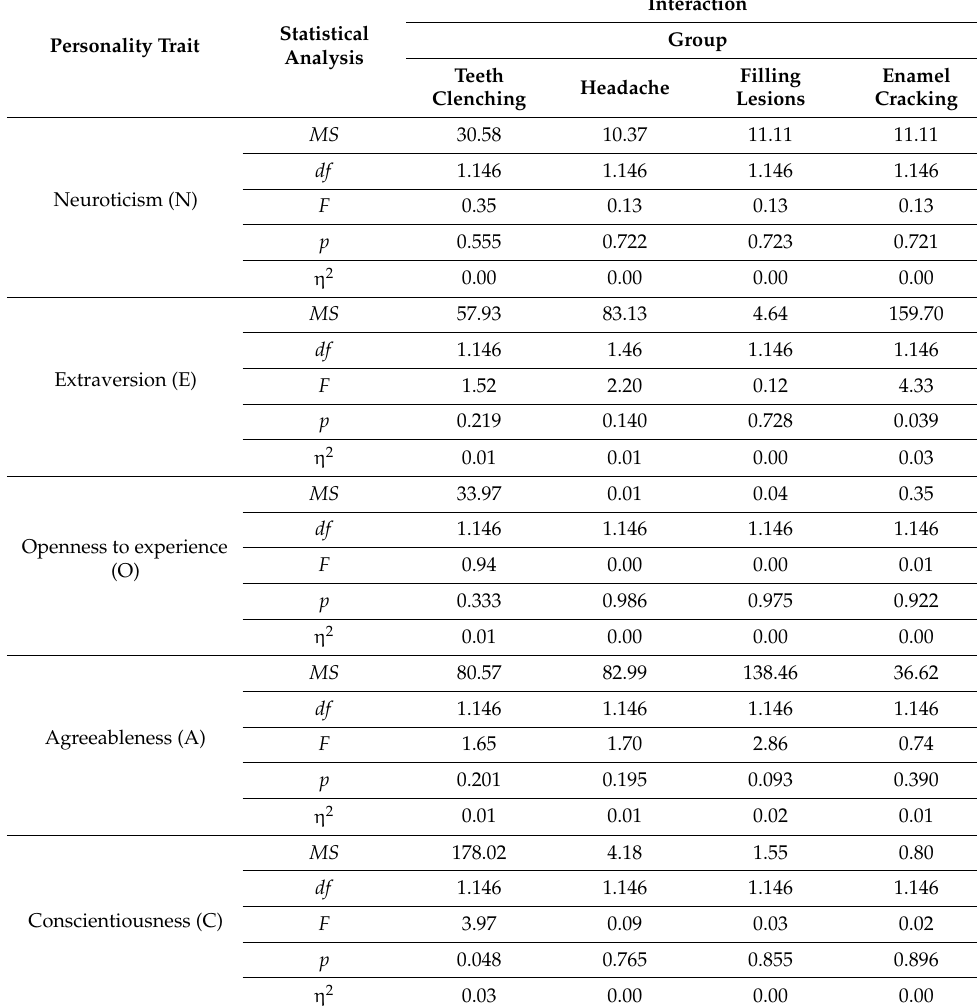
Table 2. Interaction effect